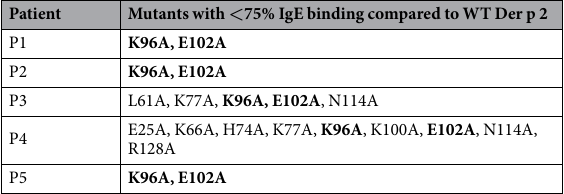
Patient Mutants with < 75% IgE binding compared to WT Der p 2 P1